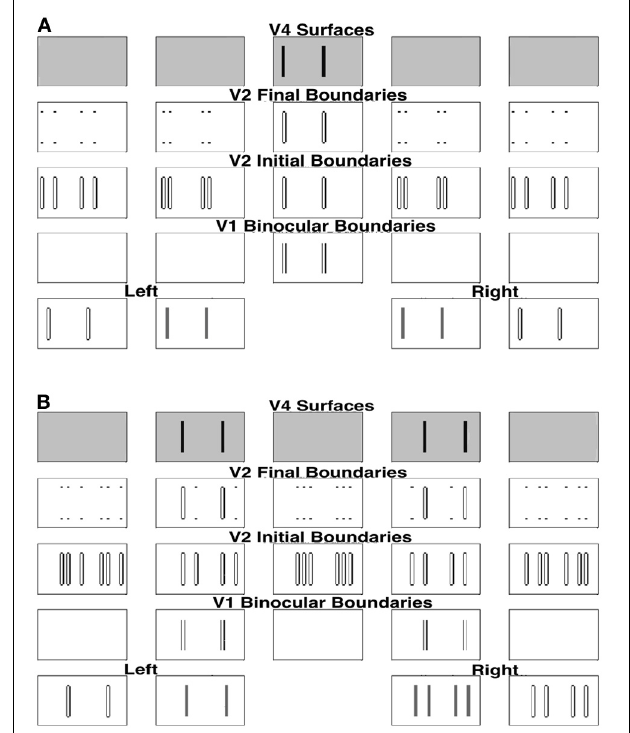
FIGURE 8 | (A) Simulation of one component of the Venetian blind effect. (B) Simulation of the other component. See the caption of Figure 6 for an explanation of the variables being simulated, and the text for further